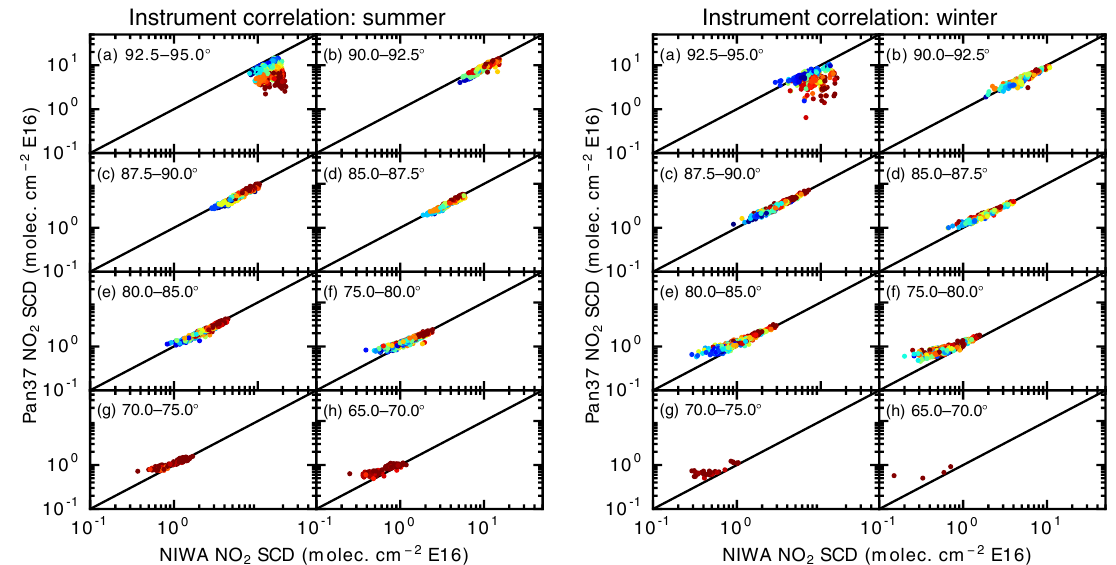
Figure 4. Correlation plots for data collected by the Pandora and M07 instruments broken into austral summer and winter. Similar to Fig. 3, data were resampled to 5-minute averages and color coded according to SZA within the specified bin range. Table 5. Summary of seasonal statistics for the Pandora–NIWA intercomparison. Similar to Table 3.